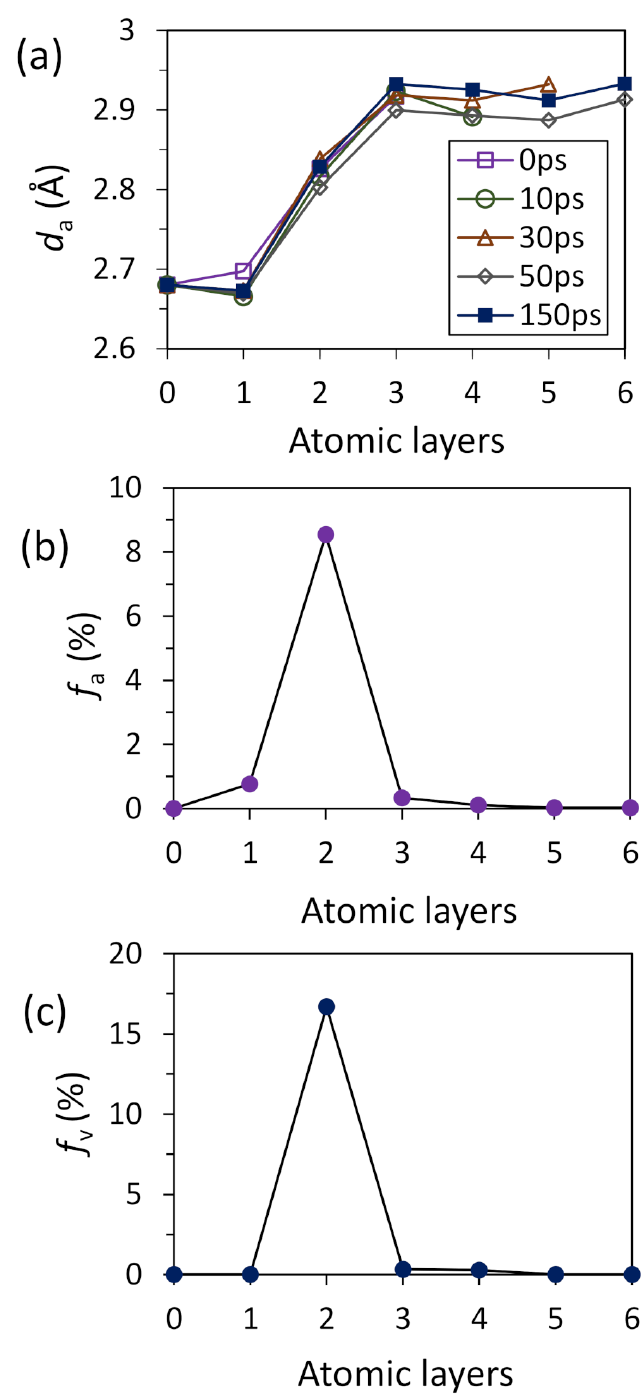
Figure 12. Evolution of atomic ordering during heterogeneous nucleation in the systems with positive misfit [38]. The simulation system has 8% lattice misfit and is equilibrated at T n = 739 K for t = 1 ns. ( a ) Average atomic spacing ( d a ) in the ordered regions of each atomic layer as a function of time showing the structural transition from the substrate to the solid is complete within 3 atomic layers (L1, L2 and L3); ( b ) accommodated misfit in each atomic layer ( f a ) showing the lattice misfit is mainly accommodated by L2; and ( c ) vacancies in each atomic layer ( f v ) showing the misfit is accommodated in L2 by formation of vacancies in